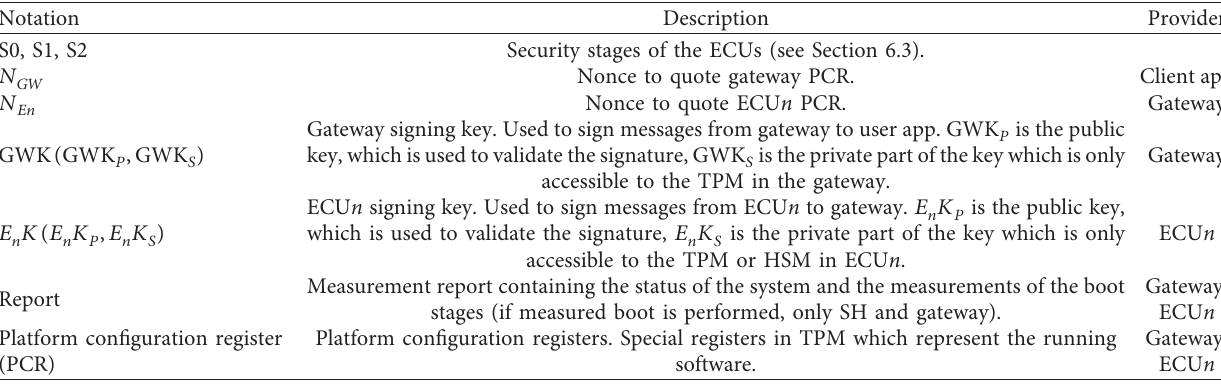
Figure 4: In-vehicle network architecture with the attack path of the attacker and the communication path for VeSIPreS. Table 2: Notations used in